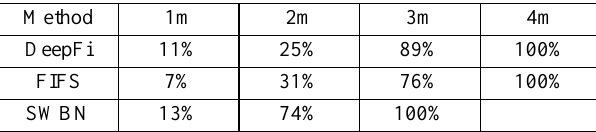
Table 3. Percentage of positioning errors for different positioning